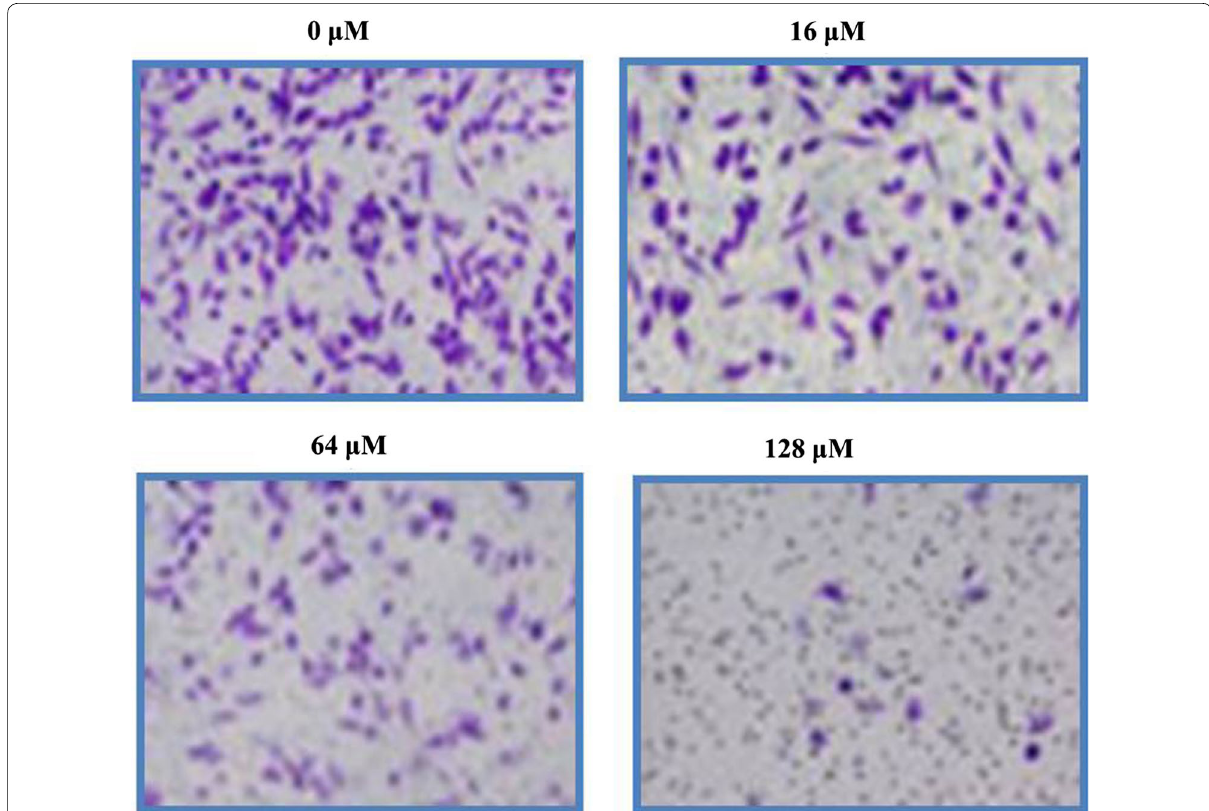
Fig. 8 Transwell chambers assay results indicating the number of migrated HeLa cells after garcinone-E treatment. Individual separate experiments were implemented three